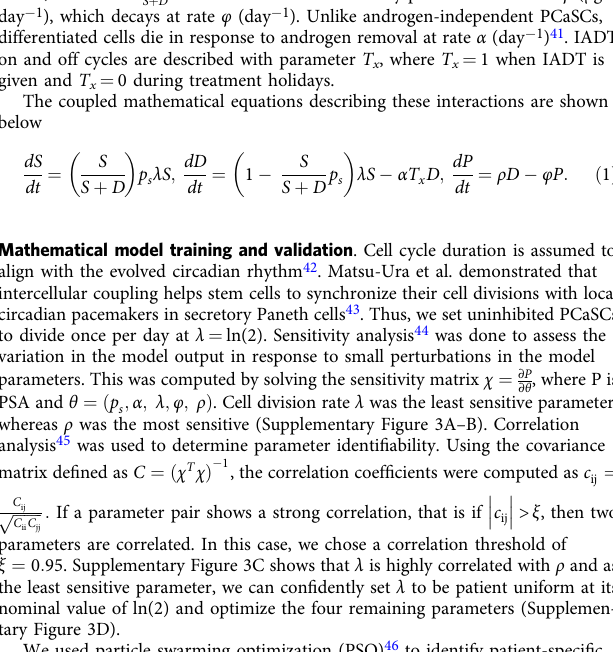
matrix de fi ned as C ¼ χ T χ ð